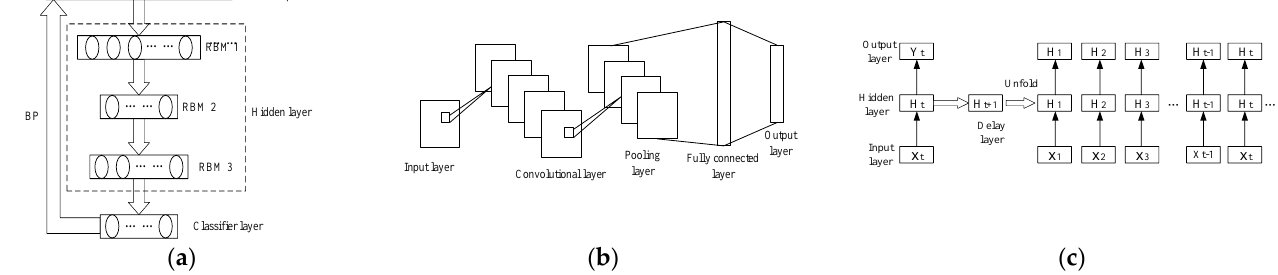
Figure 5. Deep learning structure : ( a ) structure of DBN; ( b ) structure of typical CNN; ( c ) structure of RNN.